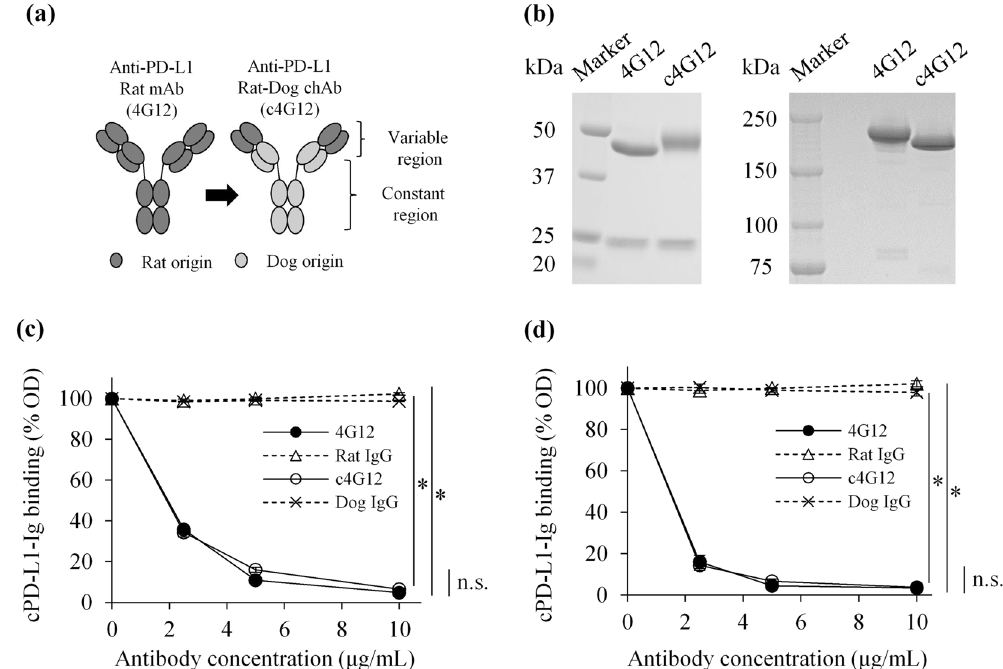
Figure 1. Preparation and evaluation of canine chimeric anti-PD-L1 mAb c4G12. ( a ) Schematic image of rat mAb and canine chimeric mAb. ( b ) Expression and purification of c4G12. CHO-DG44 cell lines which stably produce c4G12 were established and the culture supernatant was purified by protein A derivative. SDS- PAGE and Coomassie brilliant blue staining were performed and the images were analysed by densitometry to evaluate the protein purities. Left panel, reduced condition; Right panel, non-reduced condition. Rat mAb 4G12 was used as a control protein. Full-length gels are presented in Supplementary Figure S4. ( c ) Blocking of PD-1/ PD-L1 binding by c4G12. cPD-1-Ig was coated on a microwell plate and binding of cPD-L1-Ig, which had been preincubated with various concentrations of anti-PD-L1 mAbs 4G12 or c4G12, was detected on the plate. Rat IgG and dog IgG were used as control antibodies. ( d ) Blocking of CD80/PD-L1 binding by c4G12. cCD80-Ig was coated on a plate and cPD-L1-Ig binding was evaluated as described above. Each point represents a mean value of relative OD (%) obtained from three independent experiments. Error bar; SE. Statistical analysis was performed by Tukey’s test. * p < 0.05; n.s., not significant.